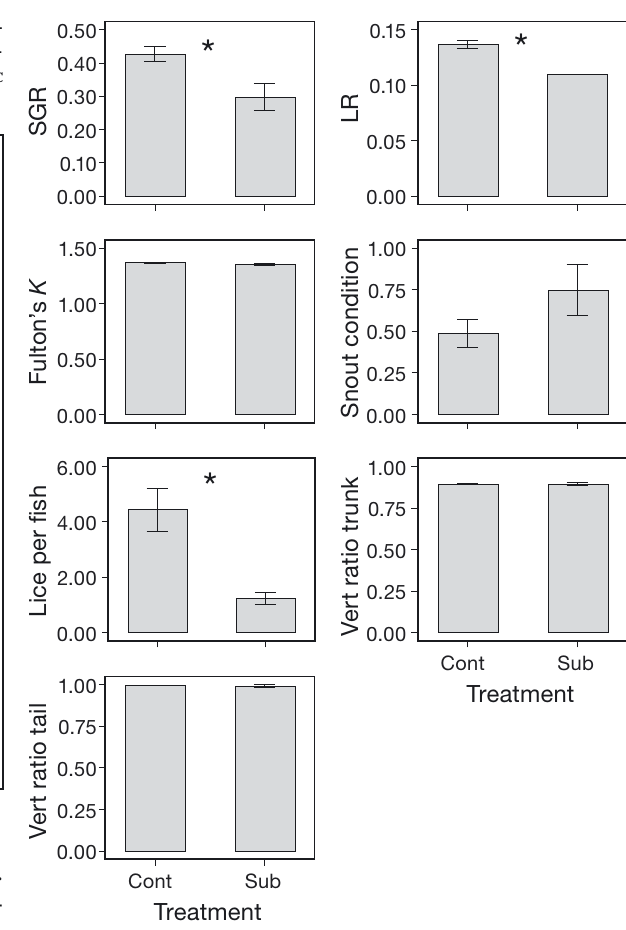
Fig. 4. Mean (± SE) specific growth rate (SGR; % d −1 ), lengthening rate (LR; % d −1 ), Fulton’s K condition factor, snout condition (where 2 = significant snout damage, 1 = any sign of skin wear or light damage and 0 = no damage), the number of immobile lice per fish and the vertebral ratio for the trunk and tail regions for fish reared in surface con- trol cages (Cont) and submerged cages (Sub). *Significance ( α = 0.05) between submerged and surface treatments